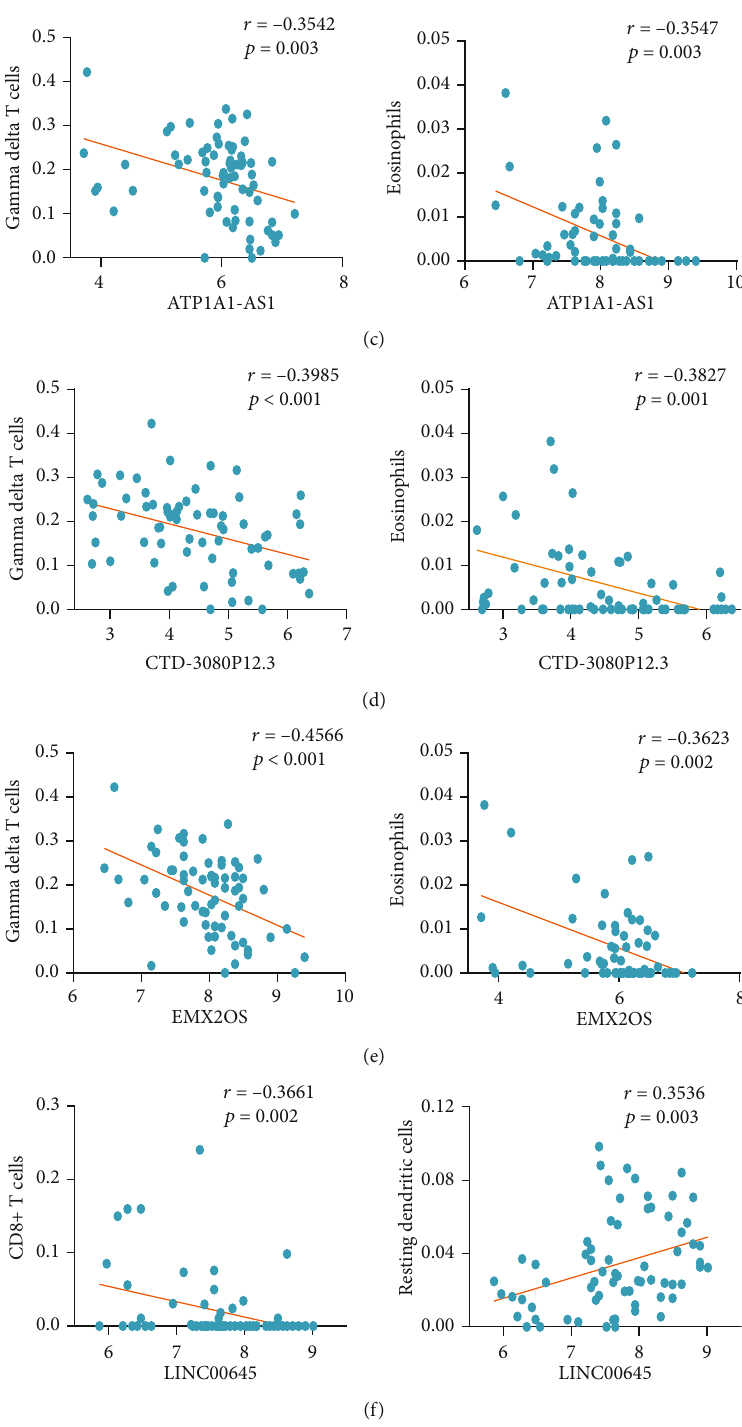
Figure 7: Pearson correlation analysis between the 4 lncRNAs and 5 common di ff erent allograft-in fi ltrating immune cell types. (a, b) CIBERSORT estimation of 22 immune cell types between AR and nonrejection specimens in the merged dataset and GSE76882 dataset, respectively. CD8 + T cells, activated memory CD4 + T cells, gamma delta T cells, resting dendritic cells, and eosinophils are 5 signi fi cantly di ff erent immune cell types common to the merged dataset and GSE76882 dataset. (c) The correlation between the expression of ATP1A1-AS1 and gamma delta T cells as well as eosinophils. (d) The correlation between the expression of CTD-3080P12.3 and gamma delta T cells as well as eosinophils. (e) The correlation between the expression of EMX2OS and gamma delta T cells as well as eosinophils. (f) The correlation between the expression of LINC00645 and CD8 + T cells as well as resting dendritic cells. CIBERSORT: cell type identi fi cation by estimating relative subsets of RNA transcripts; AR: acute